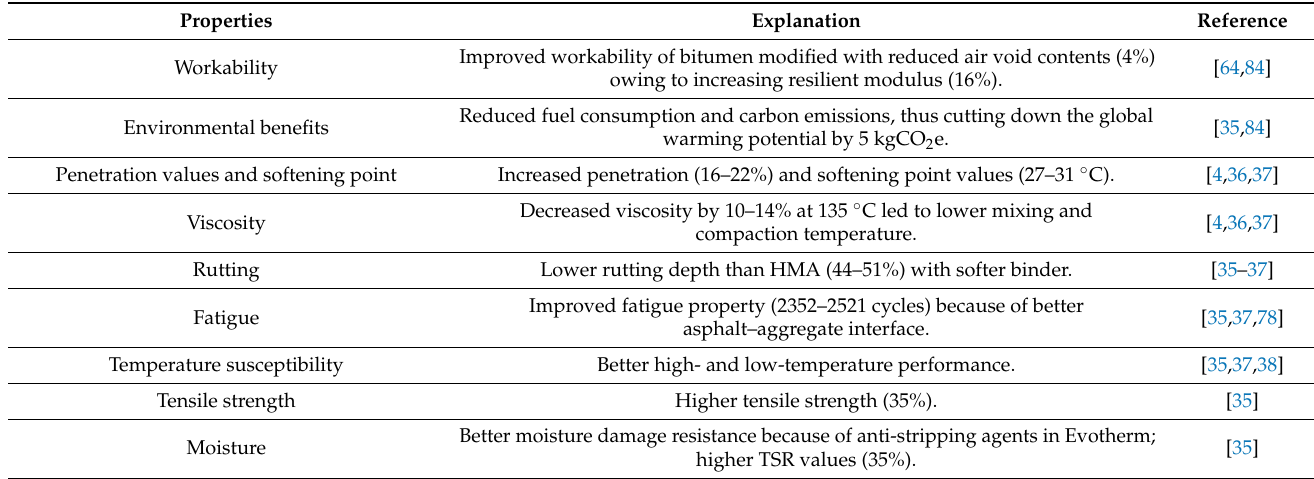
Table 19. Significant properties of Evotherm